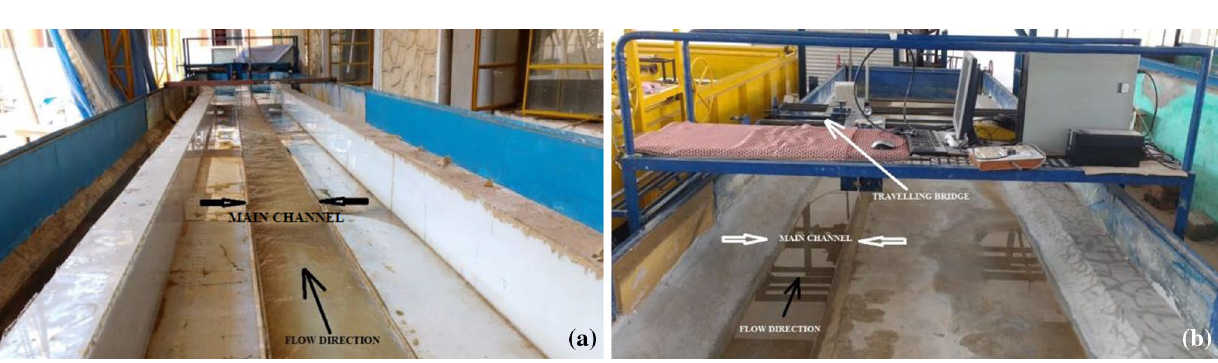
Fig. 1 Cross section of experimental channels of NITR a rectangular, b trapezoidal